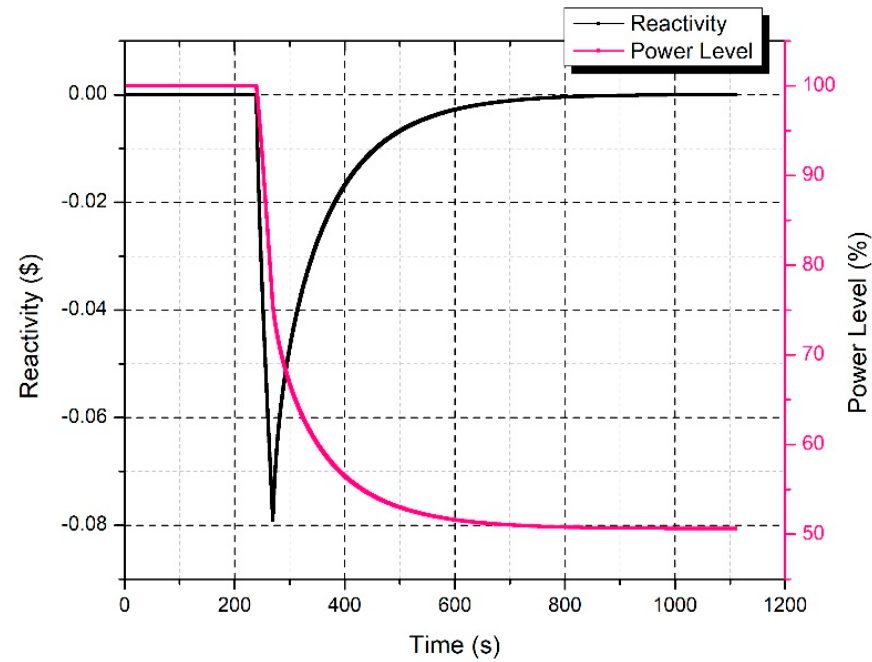
Figure 15. Reactivity insertion by regulating rods for a 50% power decrease.